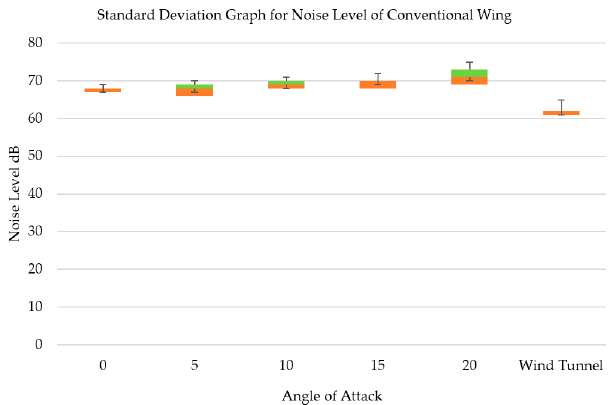
Figure 30. A graph showing the standard deviation of noise level for the conventional wing.